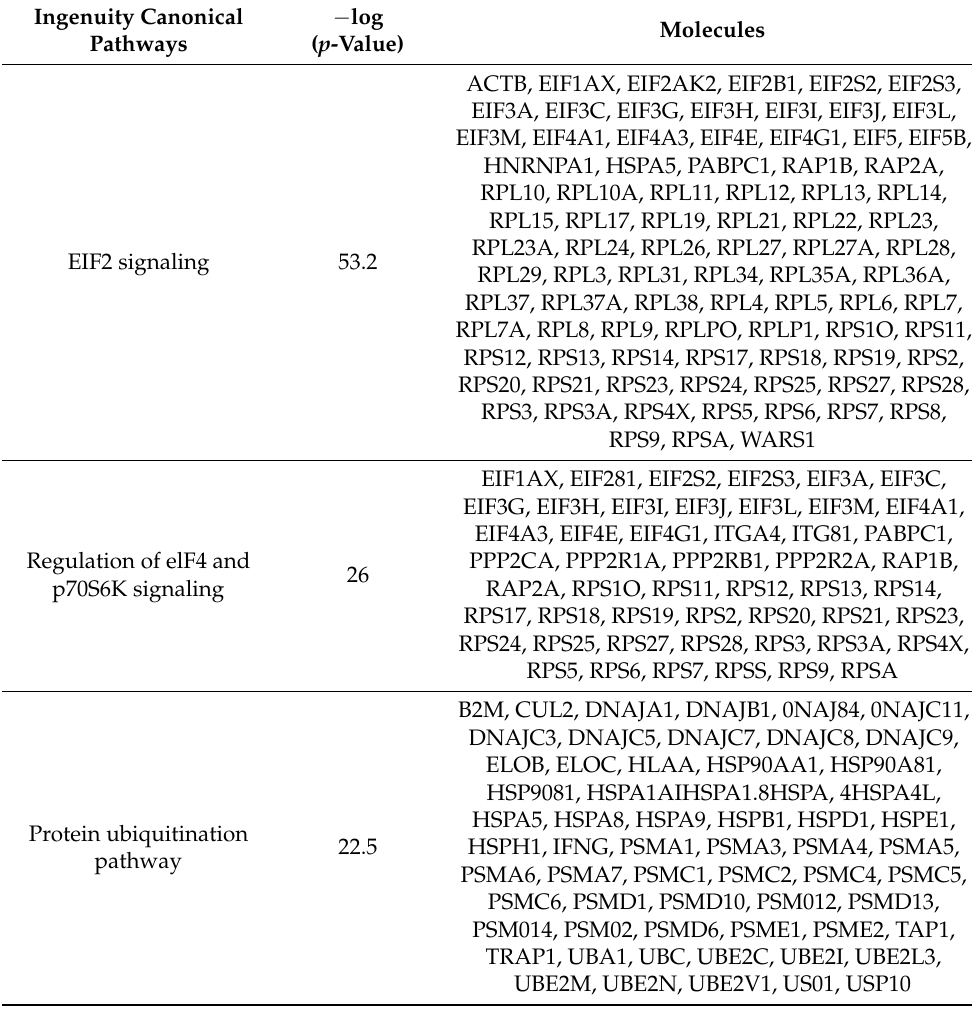
Table A2. Canonical signaling pathways activated in Molt4 cells after a UHRF1 knockdown.